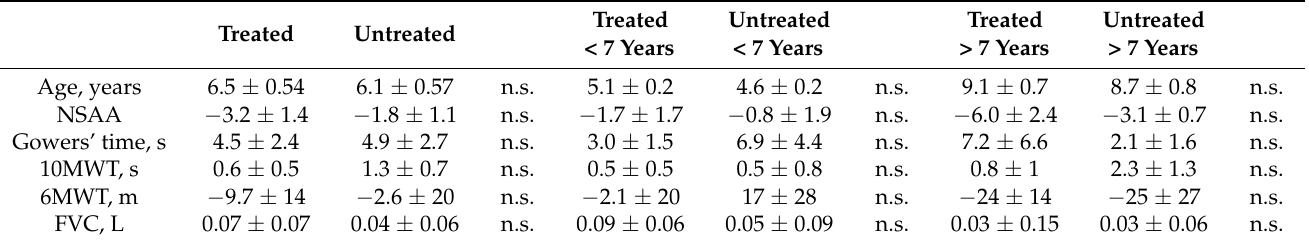
Table 2. Change in outcomes at T12 vs. T0 in the treated and untreated patients, all grouped together ( n = 17 and 17, respectively) and divided according to age < 7 years ( n = 11 and 11, respectively) and age > 7 years ( n = 6 and 6, respectively). Data are expressed as mean ±